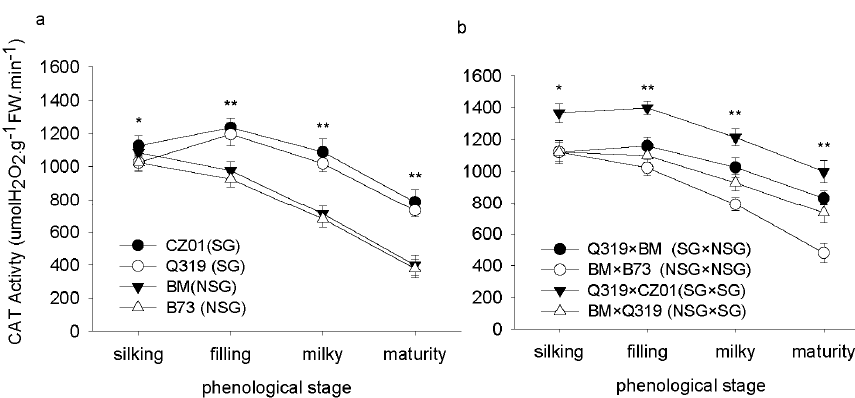
Figure 3. Catalase (CAT) activity in ear leaves from different maize genetic backgrounds after silking. Values are means ± standard deviation ( n = 3). * indicates a significant difference between treatments at p < 0.05. ** indicates a significant difference between treatments at p < 0.01. ( a ) represents inbred lines, ( b ) represents hybrids. SG1 and SG2 are two types of maize for a higher stay-green ratio; CZ01, Q319, BM, B73 are the names of maize varieties.